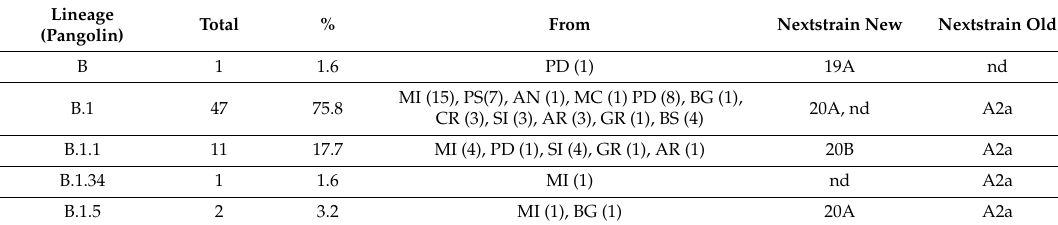
Table 1. Pangolin lineage classification of 62 Italian strains included in the